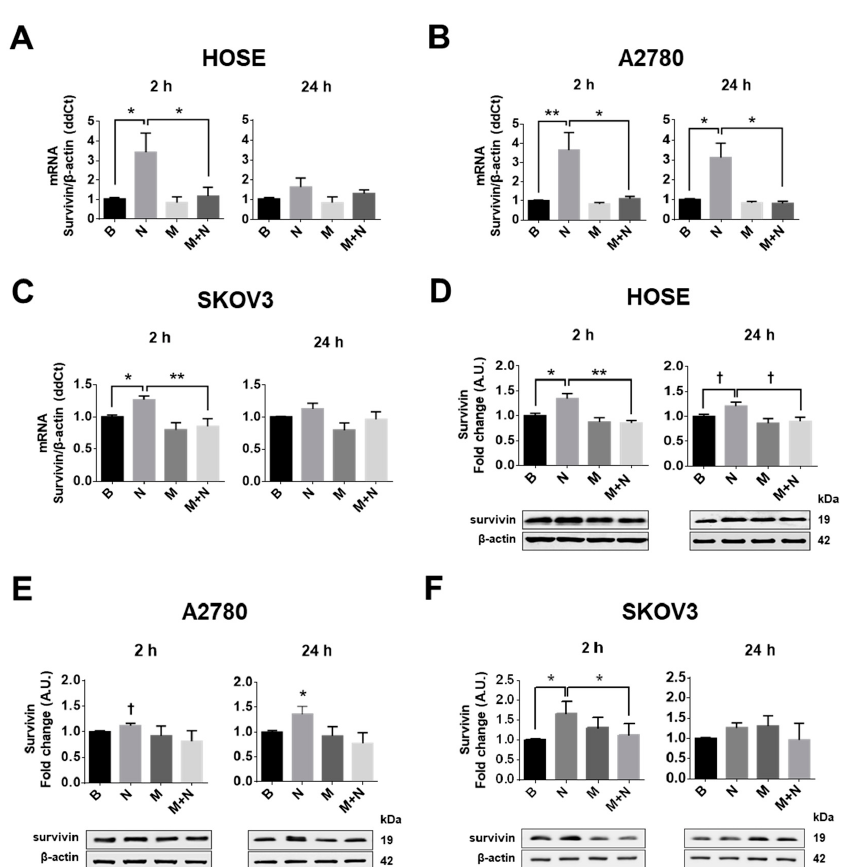
Figure 3. Metformin decreases the NGF-dependent increase in survivin expression in ovarian cells. Ovarian cells were treated with metformin 10 mM for 48 h and/or NGF 100 ng/mL or 150 ng/mL (A2780/HOSE cells and SKOV3 cells, respectively) for 24 h or the last 2 h. Then, survivin mRNA was detected in the ovarian cell lines HOSE, A2780 and SKOV3 by RT-PCR and protein levels were determined by Western blotting. ( A – C ) mRNA levels of survivin in the ovarian cell lines following metformin and NGF treatment. ( D – F ) Western blots of survivin in ovarian cell lines. N = 4 experiments per condition. * p < 0.05; ** p < 0.01 as indicated or with respect to basal condition. Statistical analysis: Kruskal–Wallis and Dunn´s post-test. † p < 0.05 with respect to basal condition or where indicated using the Mann–Whitney test. B: basal condition (without stimuli), N: NGF, M: metformin treatment.